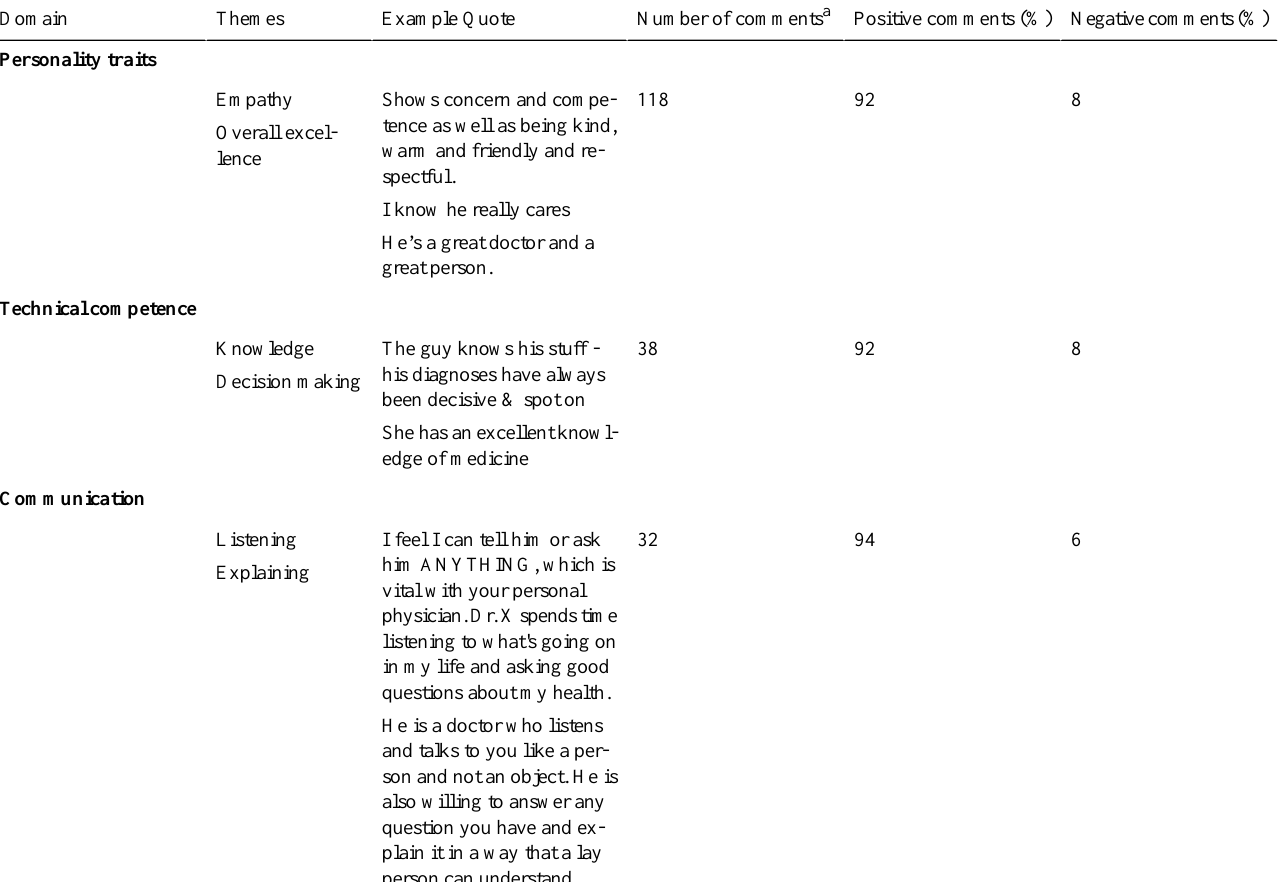
Table 1. Major themes in reviews of long-term